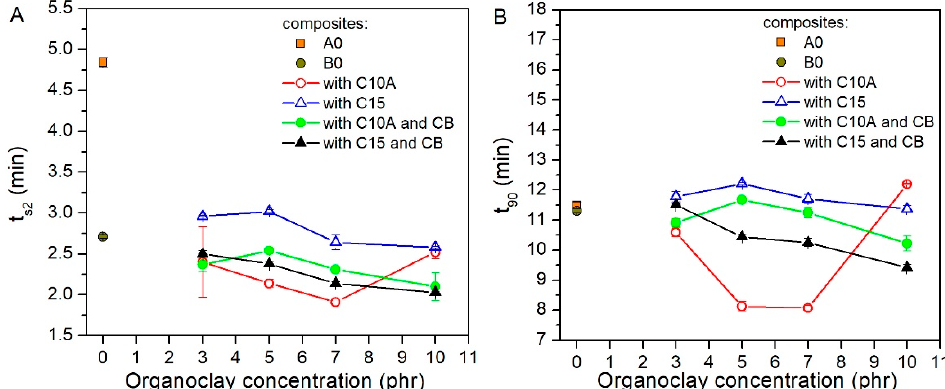
Figure 5. Curing times of rubber nanocomposites. ( A ) Vulcanization start time (t s2 ). ( B ) Time at 90% for vulcanization degree (t 90 ).